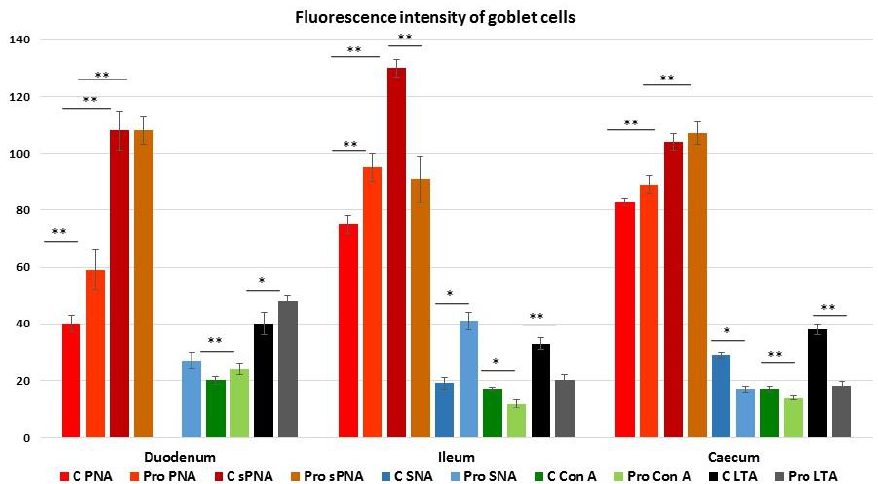
Figure 7. Quantification of Peanut agglutinin (PNA), sialidase (s)PNA, Sambucus nigra agglutinin (SNA), Concanavalin A (Con A) and Lotus tetragonolobus (LTA) fluorescence signals in the intestinal goblet cells of C and P guinea fowls. Data show the mean with error bars representing ± SE and Student’s t -test results: * p < 0.05; ** p < 0.001.